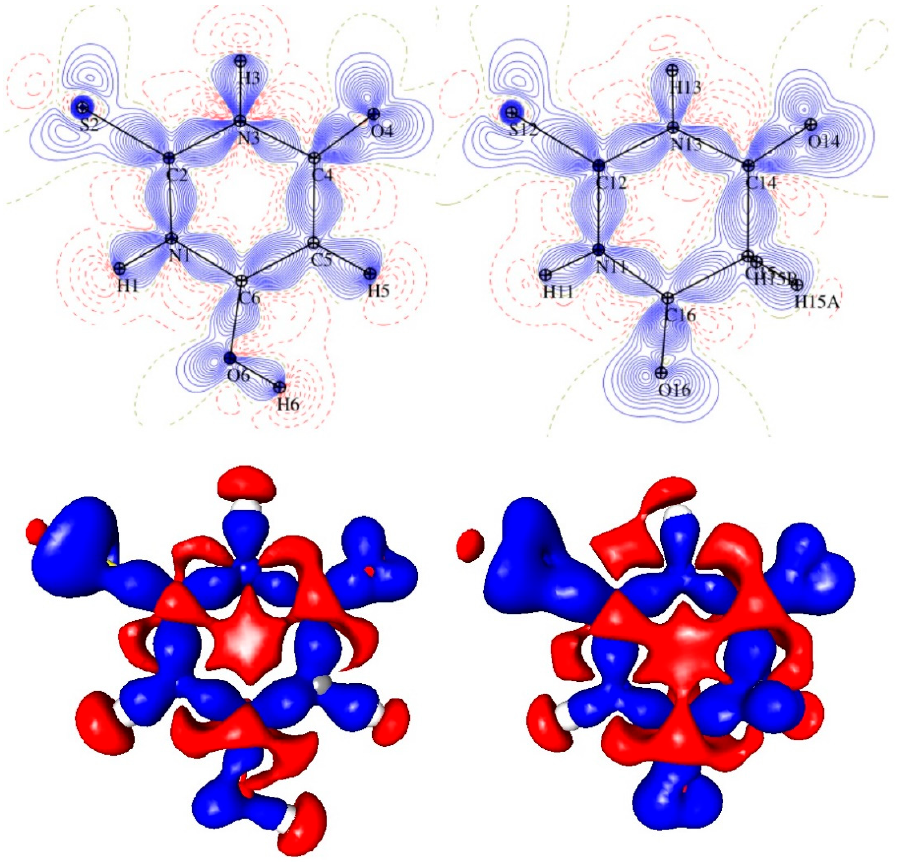
Figure 2. The 2D ( top ) and 3D ( bottom ) views of the static deformation electron density distribution in TBA molecules ( left : enol form; right : keto form). Contours are drawn at − 0.1/0.1 e.